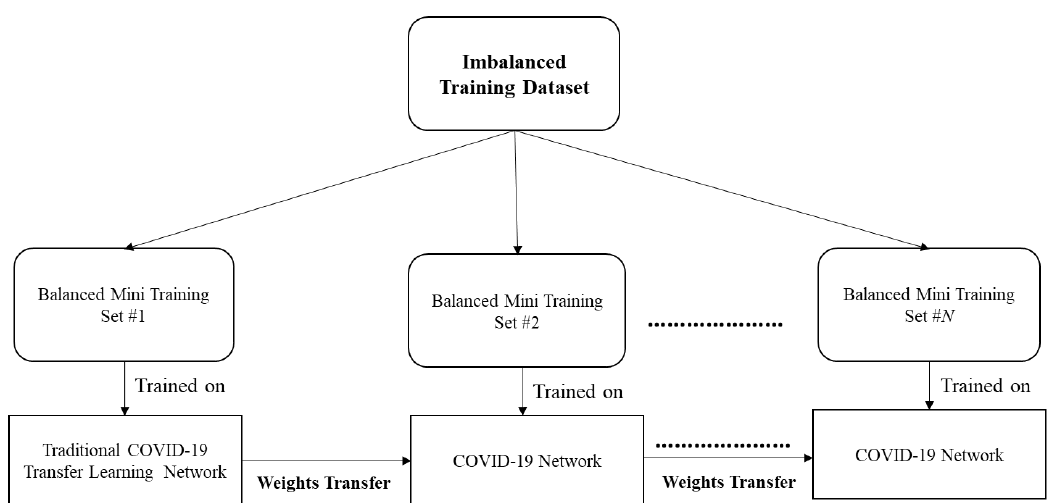
Figure 9. Recommended system: transfer-to-transfer learning approach. Each mini training set contained all the images of minority class and a randomly picked equal quantity of majority class images. Note that there was no repetition of majority class images across all mini training sets.